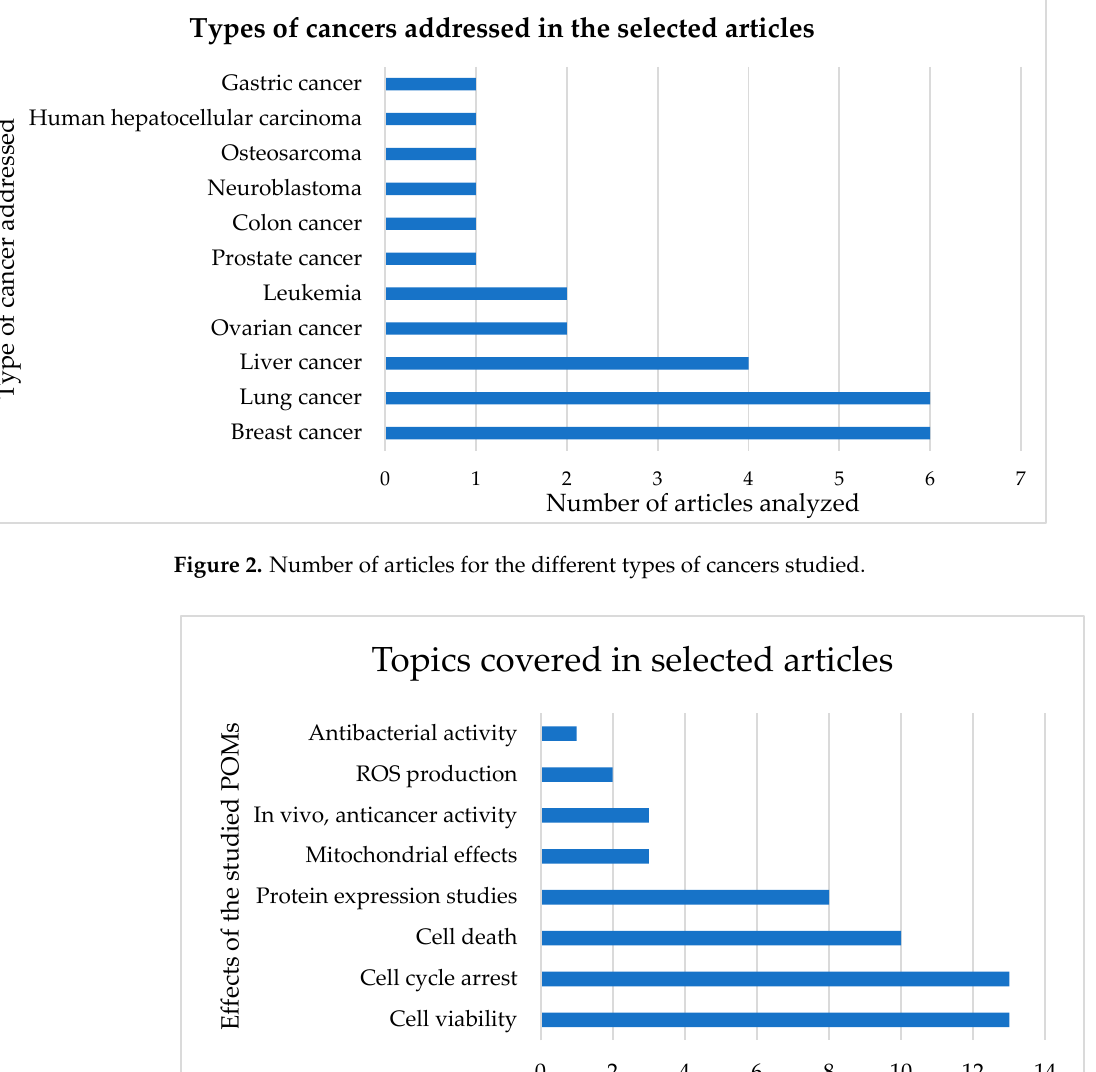
Figure 2. Number of articles for the different types of cancers studied.